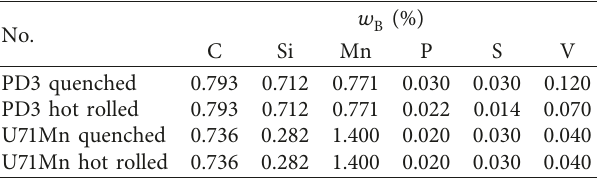
Table 1: Mass fraction of sample